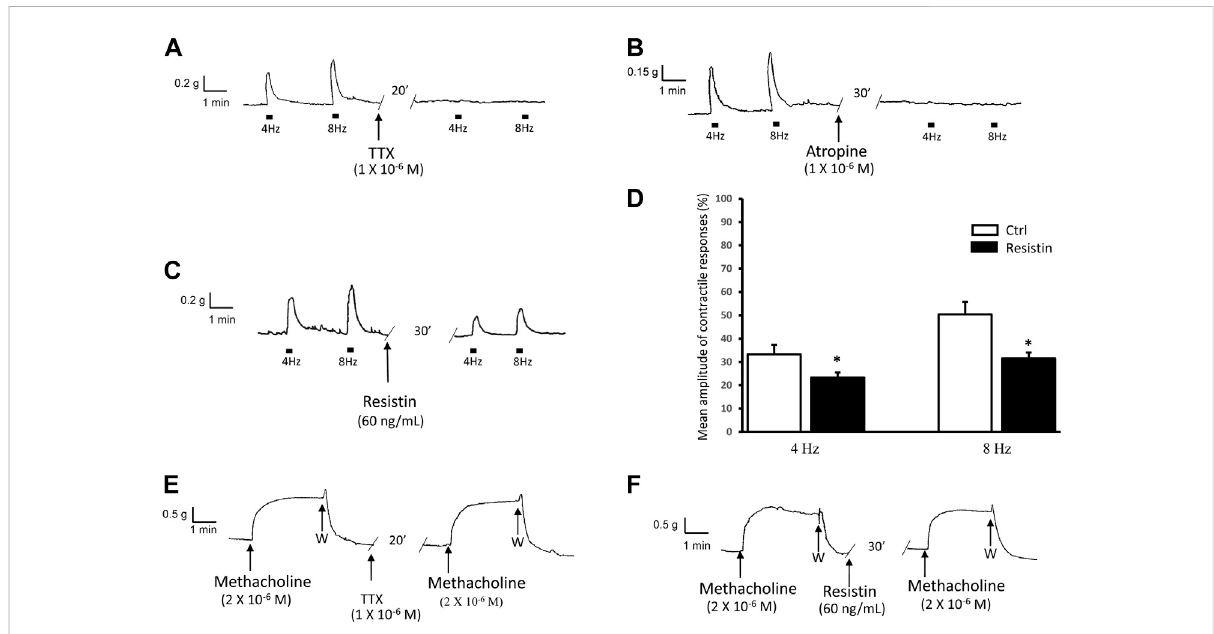
FIGURE 1 In fl uence of resistin on the neurally-evoked contractions and its lack of effects on the response to methacholine. (A,B) : representative traces showing the EFS-evoked contractile responses at 4 and 8 Hz stimulation frequency (left hand traces) and their abolition in the presence of TTX [ (A) , right hand trace] or atropine [ (B) , right hand trace]. (C,D) : representative trace (C) showing that the amplitude of the neurally-induced excitatory responses at both stimulation frequencies employed (left hand trace) is decreased in the presence of 60 ng/ml resistin (right hand trace). Bar chart (D) of the effects of resistin on the mean amplitude of the EFS-evoked contractions at 4 and 8 Hz stimulation frequency. Amplitude of contractile responses is expressed as percentage of the muscular contraction induced by 2 × 10 − 6 M methacholine, taken as 100%. All values are means ± SEM of 8 strips (from 5 animals). * p < 0.05 vs Ctrl (Student ’ s t -test). (E,F) : Representative traces showing the response to methacholine (left hand traces), whose amplitude is not affected by TTX [ (E) , right hand trace] or resistin [ (F) , right hand